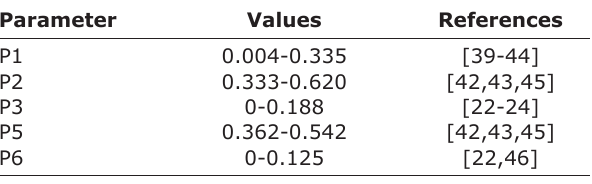
Table-2: Model parameter values for the estimation of Mycobacterium bovis milk contamination. Parameter